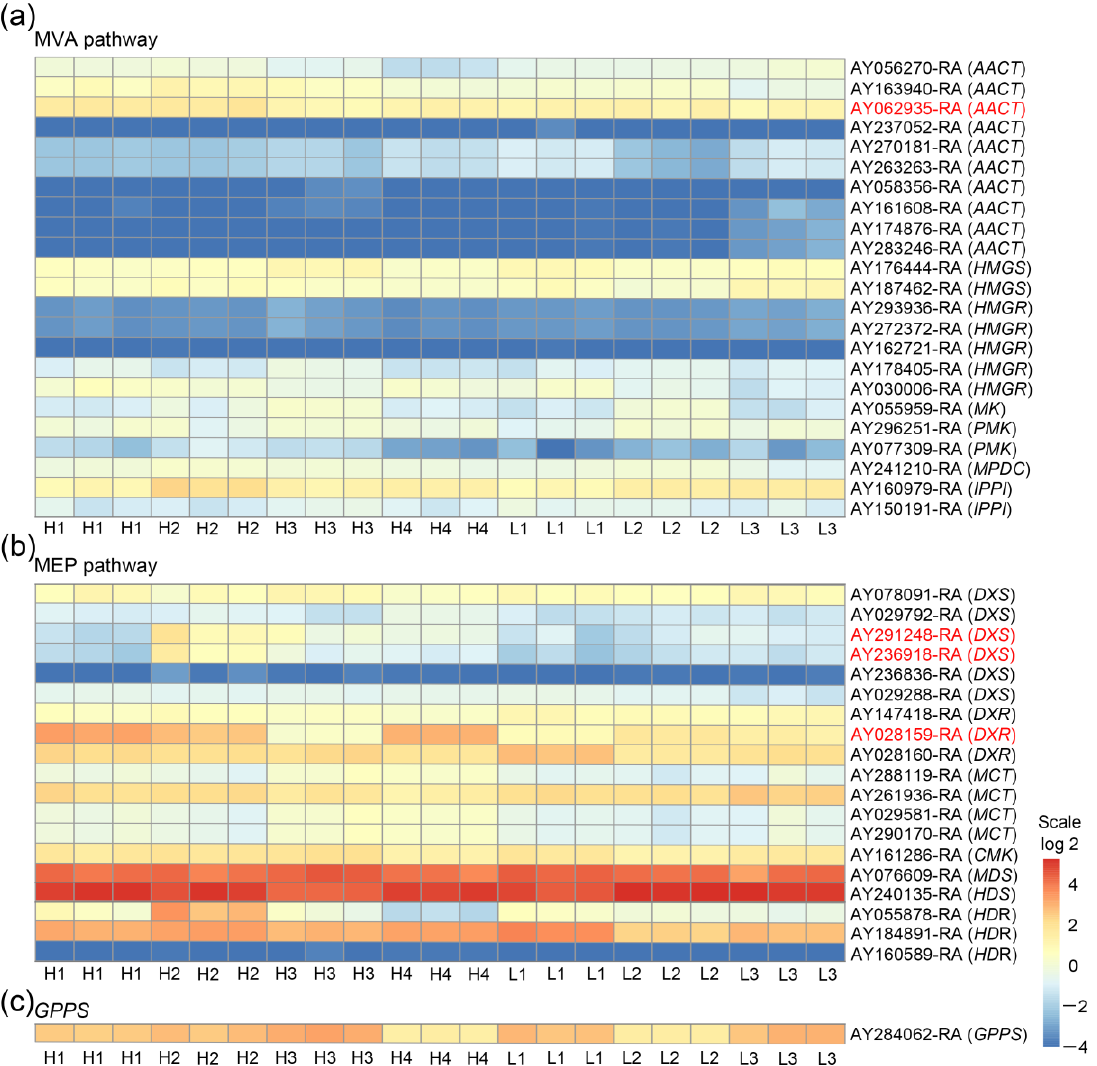
Figure 3. The expression levels of the MVA pathway, MEP pathway, and GPPS- related genes in materials with high and low thujone content. ( a ) The expression levels of genes involved in the MVA pathway. The AACT-encoding gene AY062935-RA is differentially expressed in these two groups. ( b ) The expression levels of genes involved in the MEP pathway. The DXS-encoding genes AY291248-RA and AY236918-RA and the DXR-encoding gene AY028159-RA are differentially expressed between these two groups. ( c ) The expression level of GPPS ( AY284062-RA ) in these two groups with different thujone content. DEGs are marked red. H1, H2, H3, and H4 indicate four varieties with high thujone content. L1, L2, and L3 indicate three varieties with low thujone content.